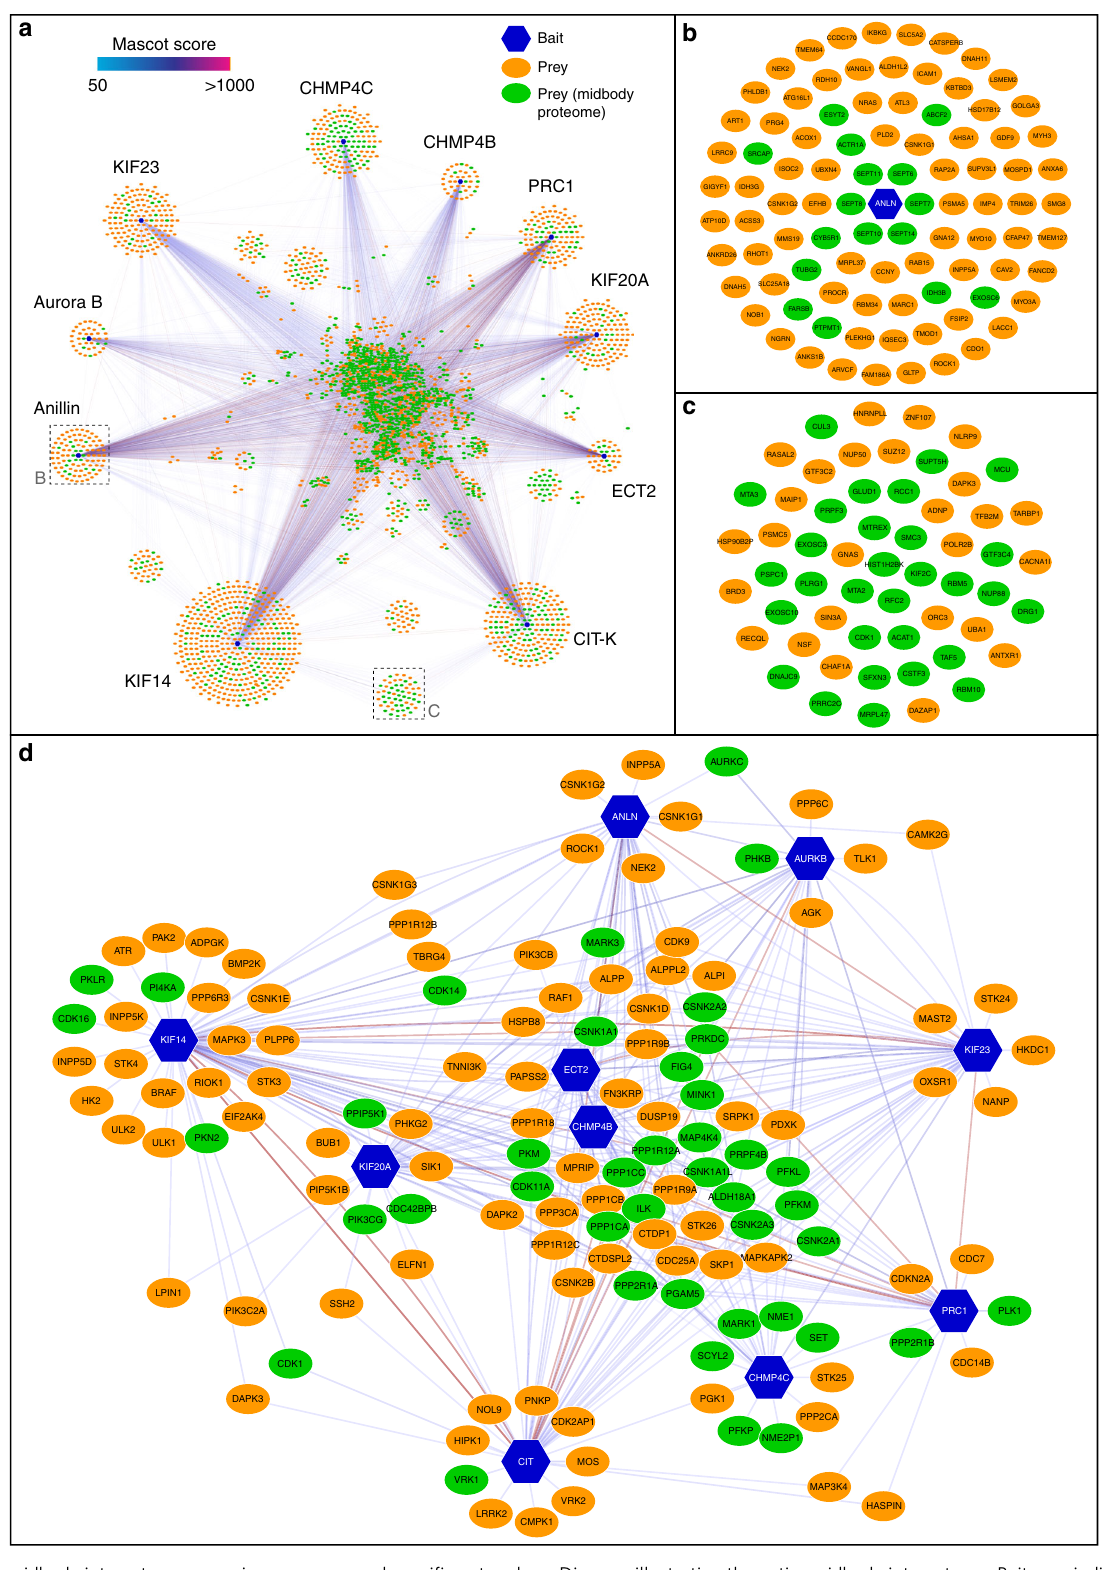
Fig. 3 The midbody interactome comprises common and speci fi c networks. a Diagram illustrating the entire midbody interactome. Baits are indicated with blue hexagons, while preys are represented as ovals, either in green, if they were also found in the midbody proteome, or in orange. The edges connecting the network nodes are colored according to their Mascot scores as indicated in the color scale bar at the top left. Preys shared by multiple baits are clustered in the center. b Enlargement of the Anillin-speci fi c sub-network shown in the corresponding inset in a . c Enlargement of the baits shared speci fi cally by CIT-K and KIF4 shown in the corresponding inset in a . d Diagram representing the phosphorylation sub-network. All nodes are labeled with their primary gene names according to the UniProt database